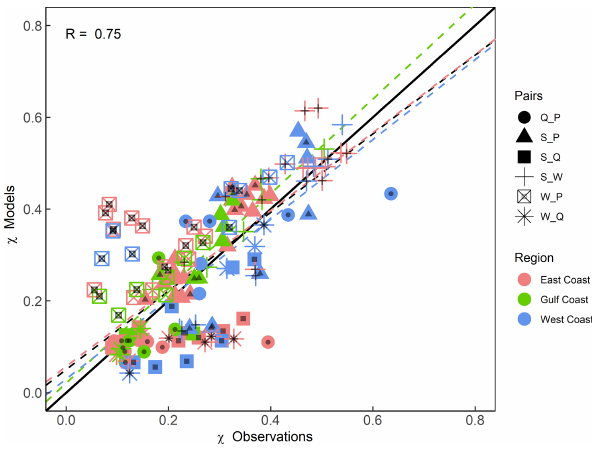
Figure 9. Scatterplot comparing extremal (tail) dependence (for q = 0 . 9) derived using observations ( x axis) and models ( y axis) using a daily time series of both variables. Colours denote the loca- tion (separated into East, Gulf, and West coasts), and markers repre- sent the different variable pairs. Black dots on the markers indicate significant difference in tail dependence structure between obser- vations and models according to KL divergence. Dashed lines show the linear regression fits corresponding to all data points (black) and for different subsets according to locations (coloured as outlined in the